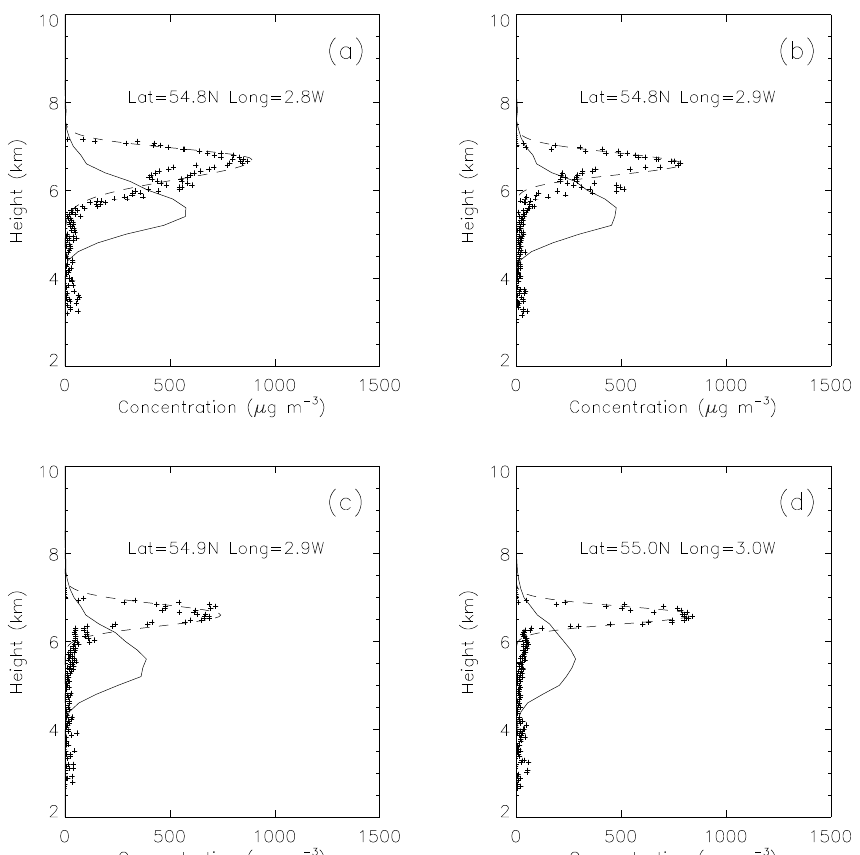
Fig. 11. Examples of concentration profiles, estimated from lidar extinction profiles on 14 May and simulated by NAME using the top emission profiles. The NAME profiles have been scaled by the distal fine ash fraction determined from the CIMLs. The small crosses are the estimates of concentration from the lidar extinction, the dashed curves show the fits to the lidar data and the solid curves are from NAME. al. (2000) and the fine ash fraction estimated at the start of the eruption by Dacre et al.